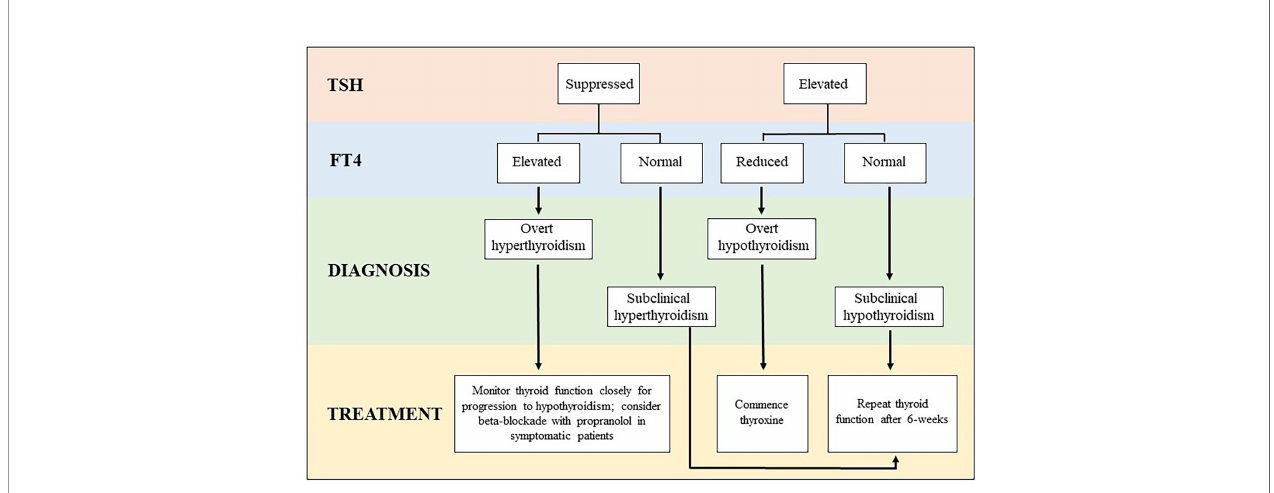
FIGURE 1 | Algorithm for classi fi cation and management of thyroid irAE subtypes. *When overt thyrotoxicosis is prolonged or severe, additional investigation with TSH receptor antibody (TRAB) and a thyroid uptake scan should be considered to exclude other etiologies of thyrotoxicosis (ie. Graves ’ disease, toxic adenoma,